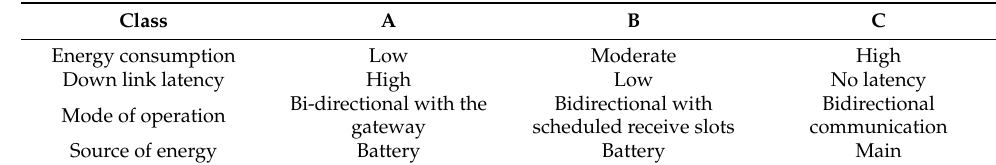
Table 6. LoRa device classes.